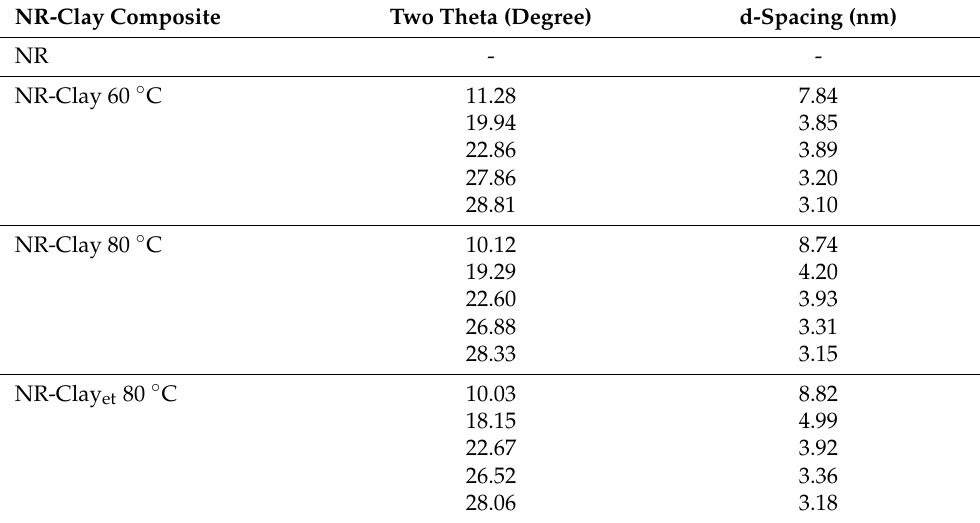
Table 2. Two theta and d-spacing of NR/Clay composite is obtained from XRD analysis.